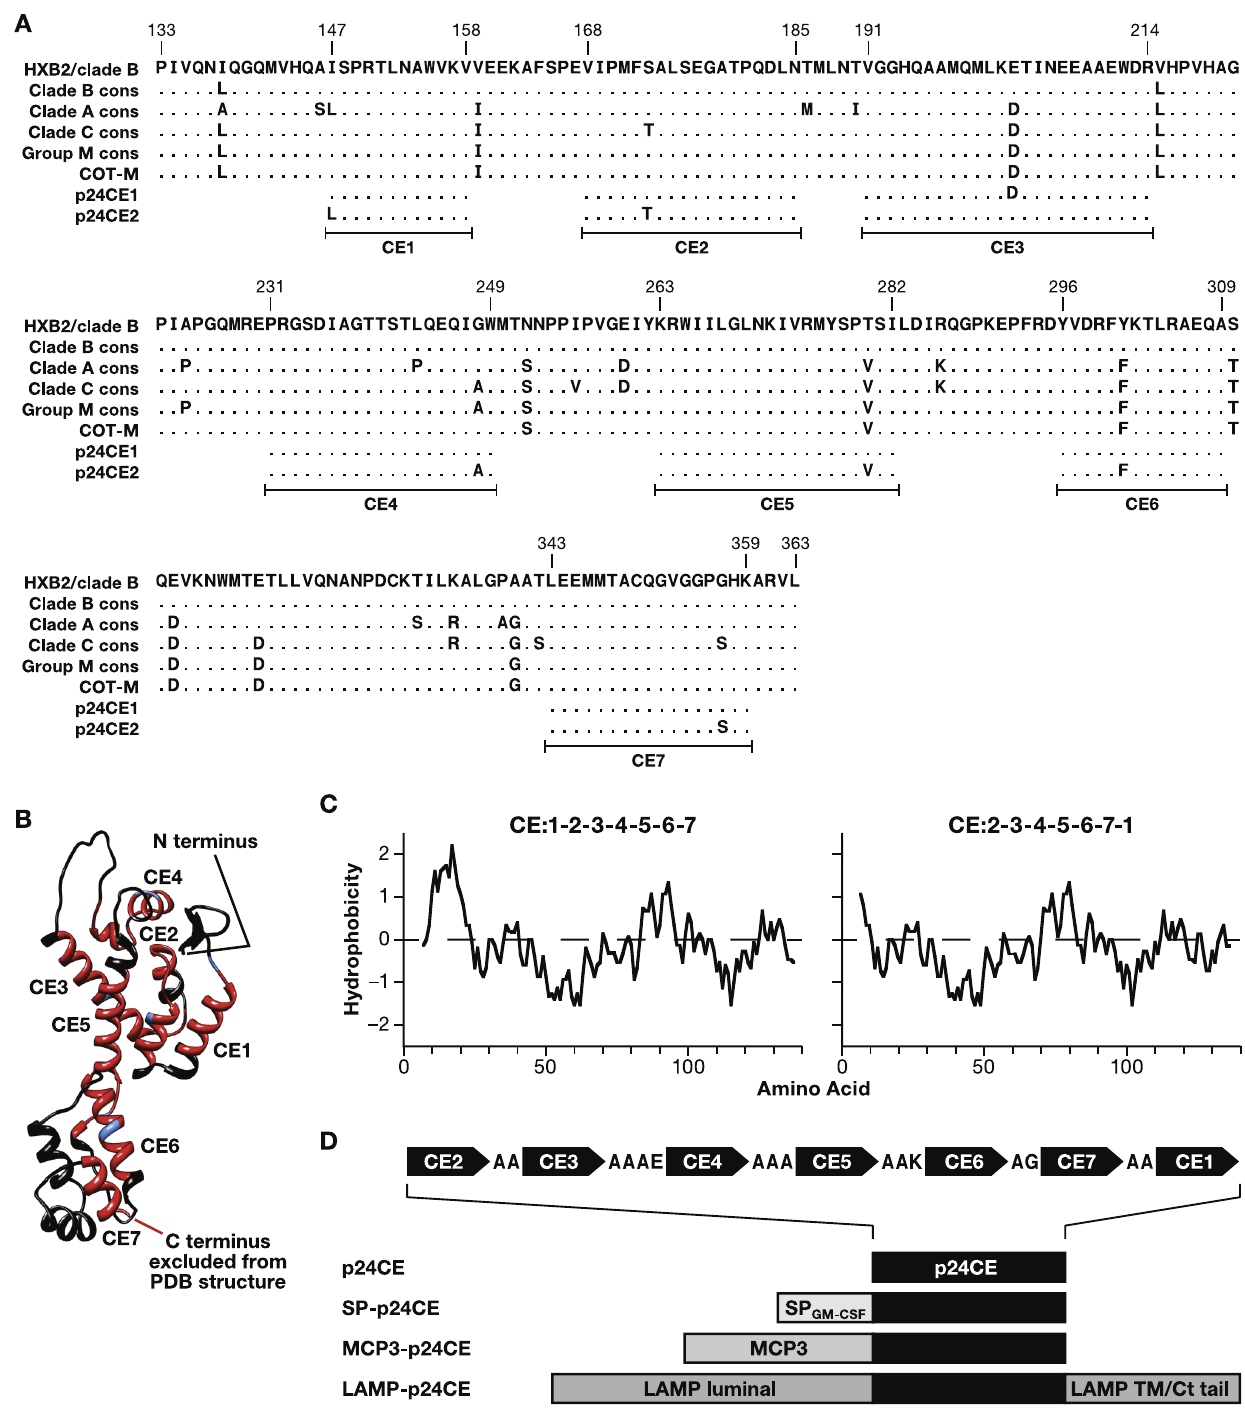
Figure 1. Design of the p24CE DNA vaccine. ( A ) Alignment of the HXB2 p24 gag protein sequences with the consensus clades A, B and C and the Group M consensus, the Group M Center-of-Tree (COT-M) and the 7 CE included in p24CE1 and p24CE2. The ‘toggle’ amino acid differences between the CE1 and CE2 sequences are indicated. ( B ) Localization of CE within the hexameric p24 gag structure. The p24 gag structure is modified from Pornillos et al. [57] and shows the location of CE1-CE7 (red), the toggle AA (blue) and the AA not included in the CE (black). The crystal structure of the hexamer was obtained from http://www.ebi.ac.uk/pdbsum/. ( C ) Kyte-Dolittle hydrophobicity plots for two different collinear arrangements of the CEs. ( D ) The p24CE (p24CE1 and p24CE2) proteins are composed of 7 CE arranged collinearly and linked via amino acid linkers. The secreted SP- p24CE contains the GM-CSF signal peptide. MCP3-p24CE is a fusion protein with the Monocyte chemoattractant protein 3 (MCP3) chemokine. LAMP- p24CE is a fusion with the lysosomal associated membrane protein 1 (LAMP-1).